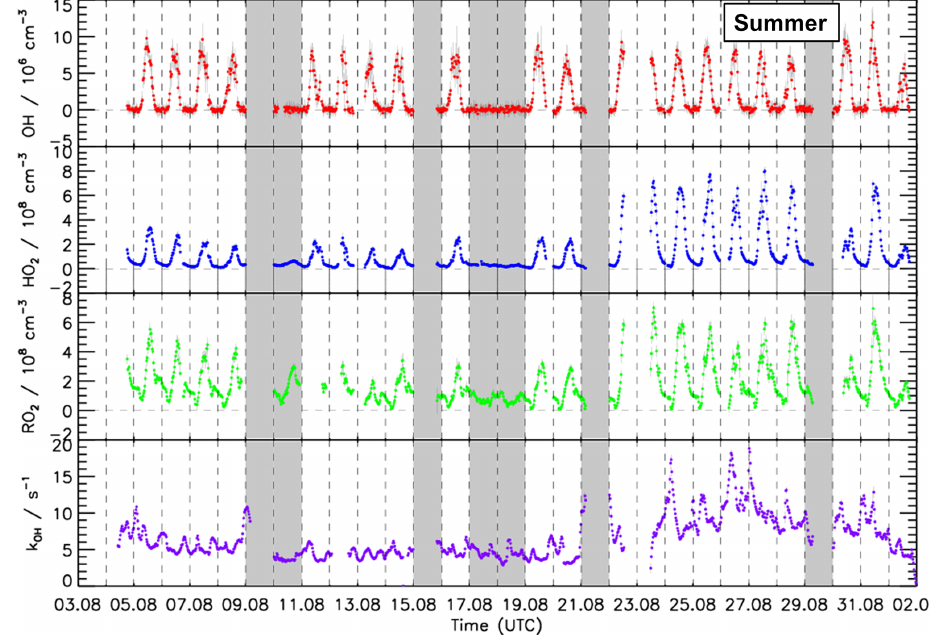
Figure 4. Time series of OH, HO 2 , and RO 2 concentration measured by the FZJ LIF–CMR instrument and measurements of the OH reactivity ( k OH ) in the summer period of the JULIAC campaign (Cho et al., 2022). Vertical bars represent 1 σ statistical errors. Vertical dashed lines denote midnight. Grey shaded areas indicate calibration days when no measurements were done and days when the chamber roof was closed due to bad weather